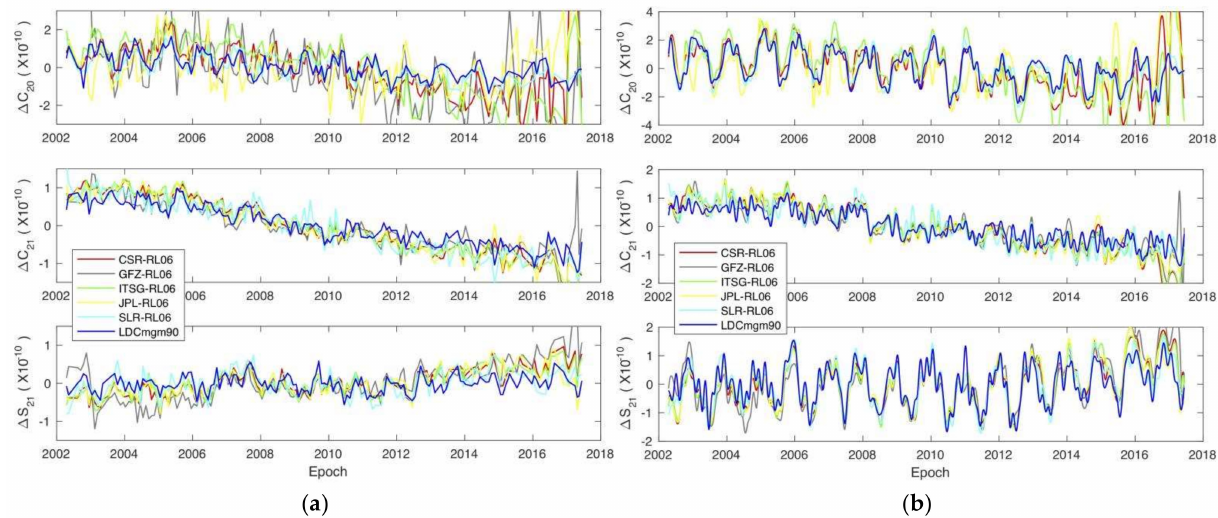
Figure 3. Stokes coefficients C 20 , C 21 and S 21 from different sources (from [33] with the authors’ permission). ( a ) GSM data for 163 months (no interpolation applied); ( b ) GSM + GAA + GAB data with cubic spline interpolations for better displays of seasonal cycles. The means of all series are removed. Reproduced with permission from Wei Chen, Scientific Data ; published by Springer Nature,